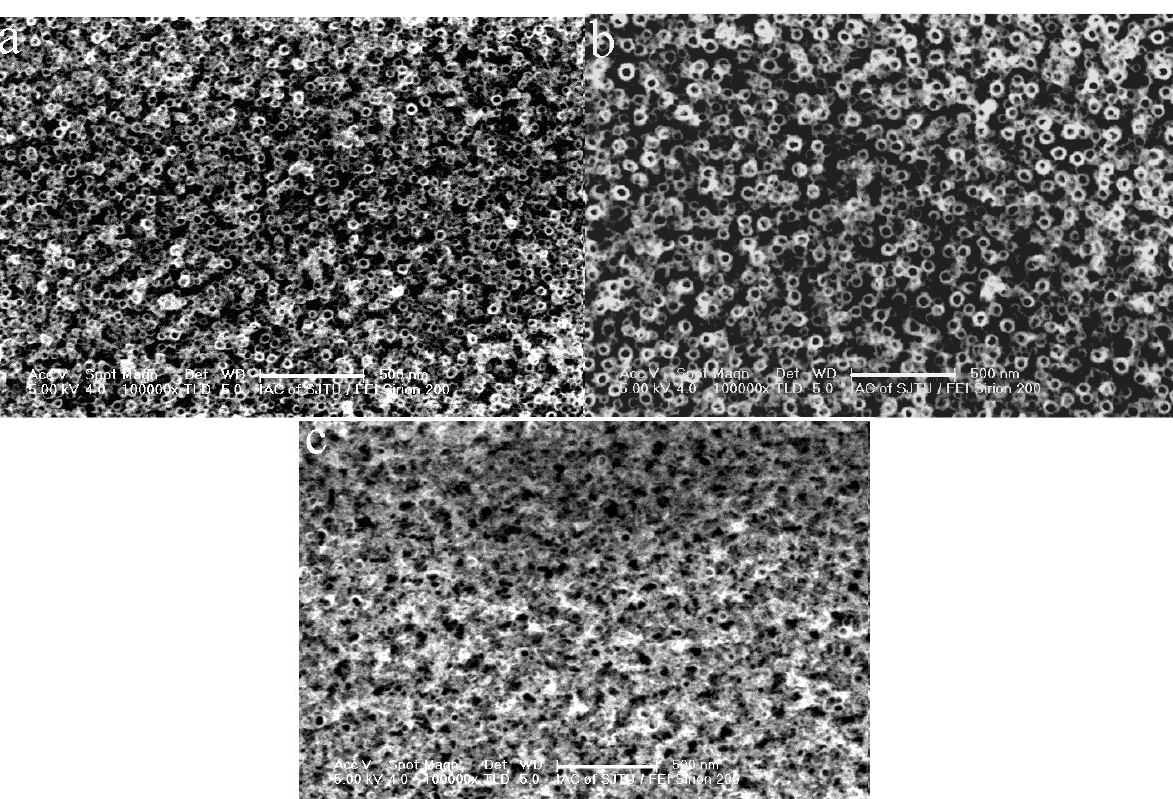
Figure 1. Top view images of as-anodized Ti-Ni-O nanostructures fabricated at different pulse voltages in a non-aqueous electrolyte of 5% ethylene glycol/glycerol containing